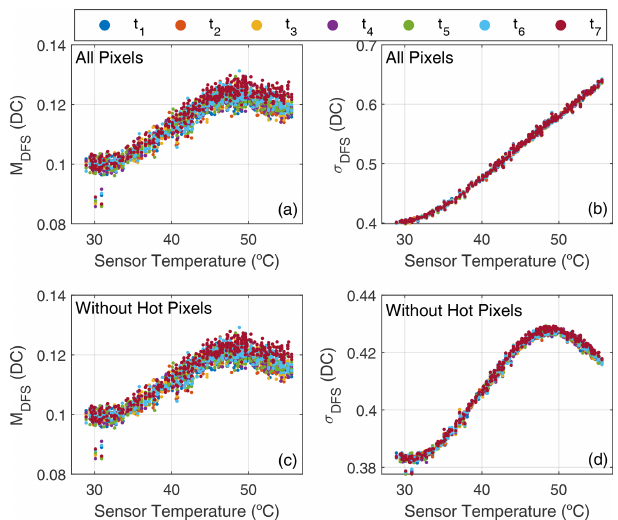
Figure 3. Mean (a, c) and standard deviation (b, d) of the dark frame signal as a function of sensor temperature for different expo- sure times. Values in panels (a) and (b) are calculated considering all pixels and (c, d) without hot